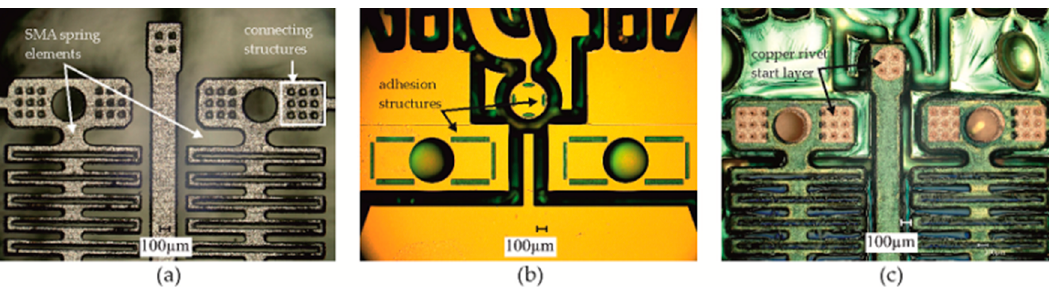
Figure 4. ( a ) Detail of a femtosecond-laser-cut SMA actuator with spring elements and connecting structures; ( b ) gold-coated silicon wafer with INTERVIA TM adhesion structures; ( c ) detail of aligned wafer and actuator mesh, connection structures with start layer of electroplated copper